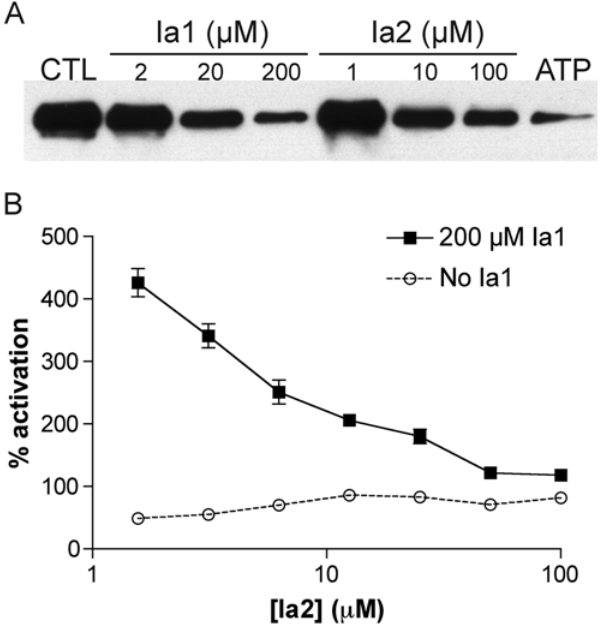
Figure 3. Ia1, Ia2 and ATP interact with a common domain within IDE. A , Ia1 and Ia2 disrupt the crosslinking of recombinant IDE with a photoaffinity ATP analogue. DMSO concentrations were maintained constant in all conditions; CTL =DMSO only; ATP =10 mM ATP. B , Activation of FRET1 hydrolysis by Ia1 can be competed away with increasing doses of Ia2. Data are mean 6 SEM for 5 independent experiments normalized to control wells containing DMSO only. All data are statistically different from controls ( P ,